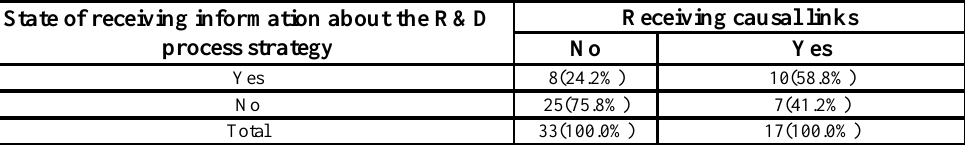
Table 14. The frequency of the state of receiving information about the R&D strategy State of receiving information about the